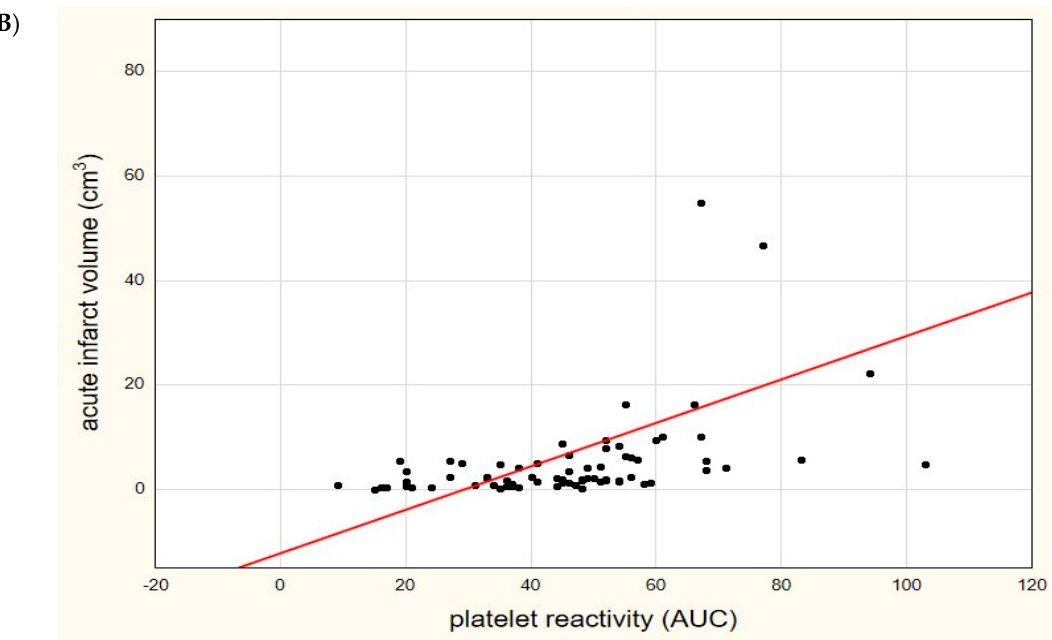
Figure 4. Significant correlation between platelet reactivity (in area under the curve units—AUC) and a volume of acute ischemic infarct (in cm 3 ) in the diffusion-weighted sequence of magnetic resonance imaging. ( A ) Initial (the first time point) platelet reactivity value, ( B ) control (the second time point) platelet reactivity value.